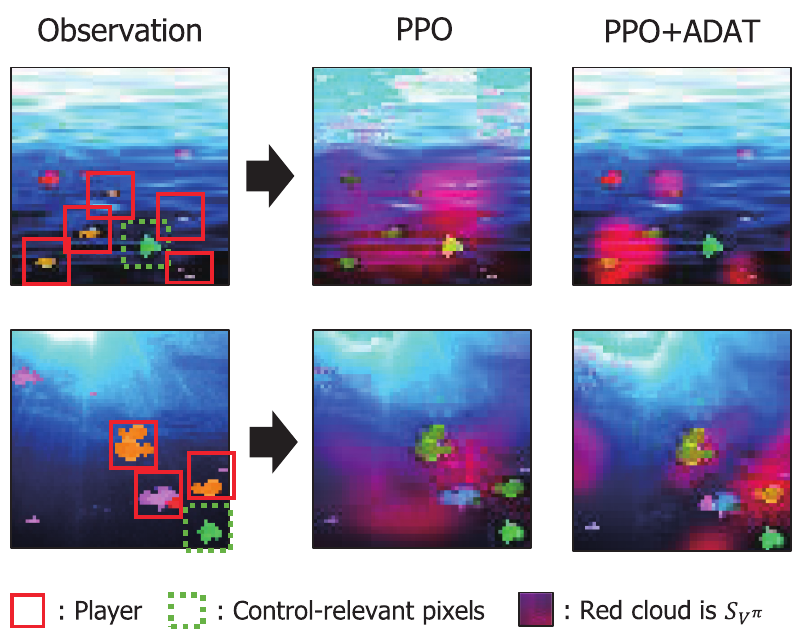
Fig 6. Saliency map of Bigfish and Plunder Games in OpenAI Progen. From left, original rendering, saliency map of the PPO, and the PPO with ADAT in